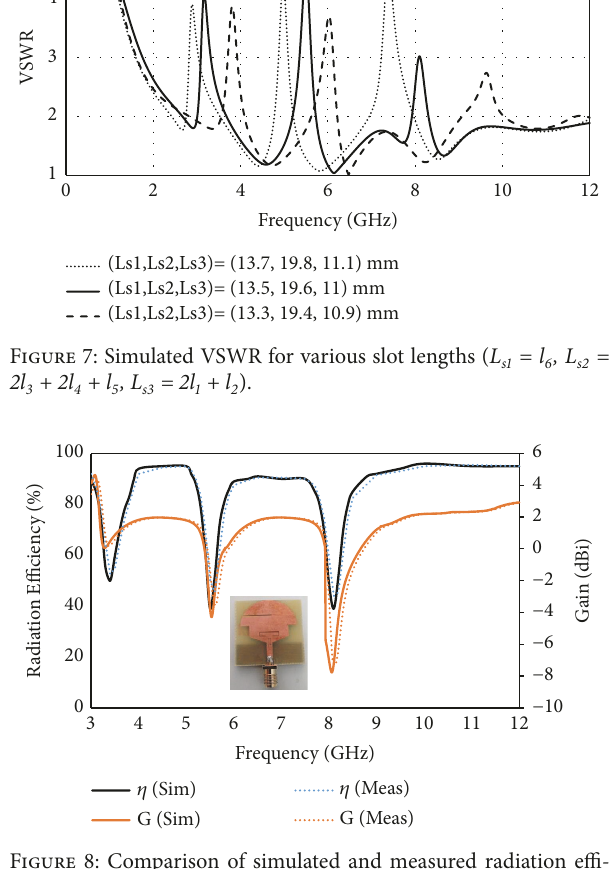
Figure 6: Simulated VSWR for different values of gap between ground and radiating patch.